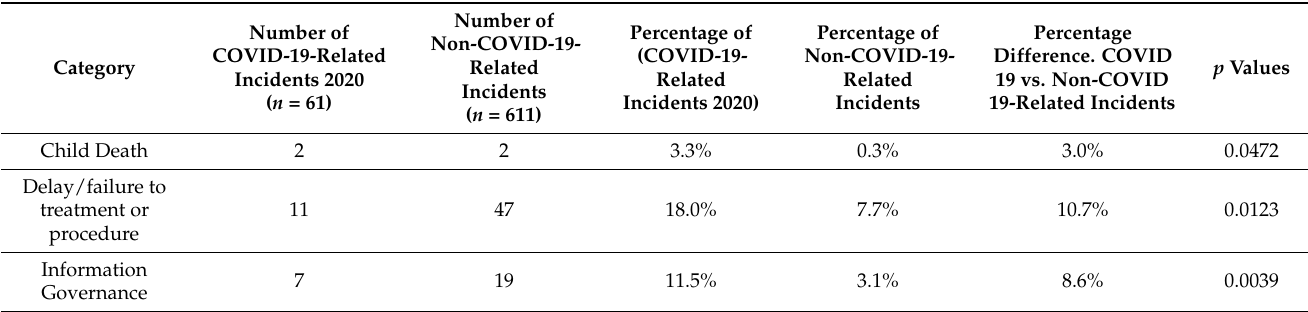
Table 1. Incident categories with statistically significant increases between COVID-19-related and